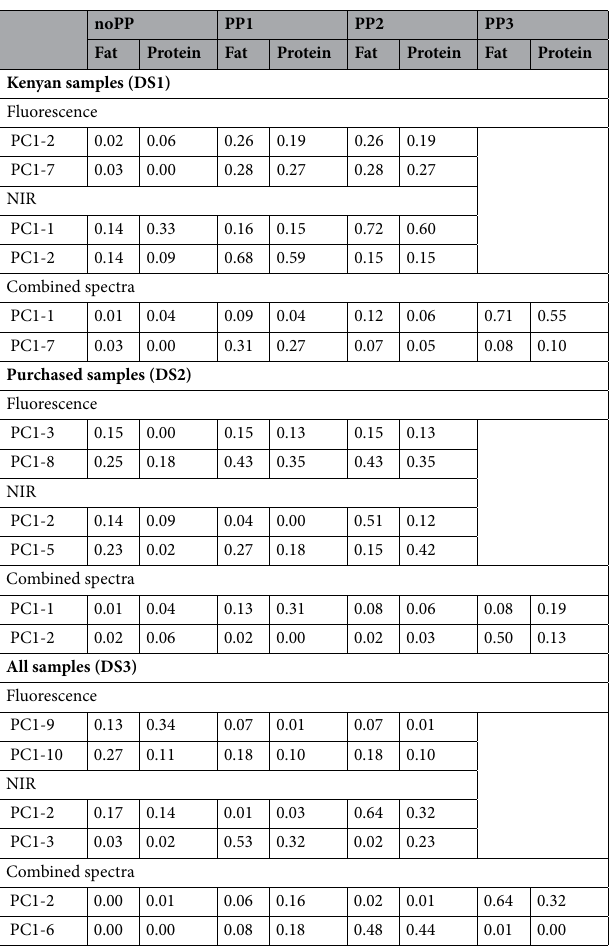
Table 2. Two best correlation results of the PCA for no and pre-processing methods for the single and combined spectra as well as all datasets (DS). R 2 is the coefficient of determination, RMSEP is the absolute root mean squared error of prediction, RMSEP range is the percentage error. PP indicates pre-processing, PP1: SNV, PP2: SNV and baseline correction, PP3: SNV, baseline correction and reducing factor for fluorescence spectra. PP is for